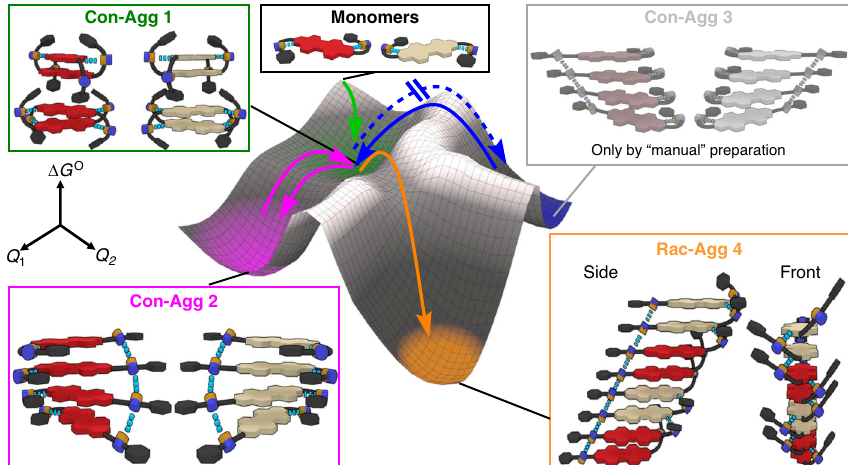
Fig. 6 Qualitative energy landscape. Qualitative energy for the supramolecular conglomerate and the racemic supramolecular polymer formation from the racemic mixture of ( R,R )- and ( S,S )-PBI . The aggregate structures corresponding to supramolecular pathways, which are directly accessible by ultrasonication of the racemic mixture ( Con-Agg 1 , Con-Agg 2 and Rac-Agg 4 ), are schematically illustrated in colour while the structure of the polymorph Con-Agg 3 , which can only be prepared by manual mixing of prefabricated ( R,R )- and ( S,S )-Agg 3 , is shown in grey. The colour code of the respective PBIs is adjusted to Fig. 1a; hydrogen bonding is indicated with blue dashes. Q 1 and Q 2 denote coordinates for the lowest-energy reaction pathway between the different